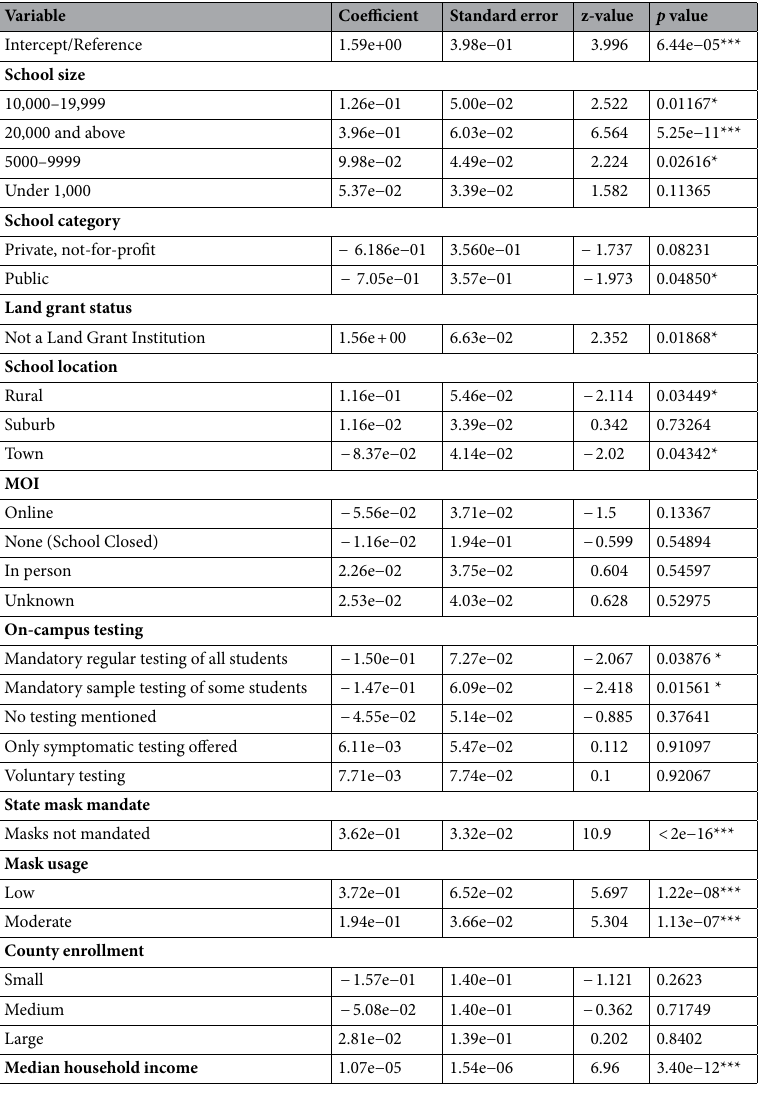
Table 6. Best overall fit model that predicts population-adjusted county-level COVID-19 cases during the fall of 2020 (September 1st–December 31st) including college/university characteristics and COVID-19 mitigation strategies. Increasing number of asterisks correspond to the increasingly significant statistical values (e.g. * = p < 0.05, ** = p < 0.01, *** = p <